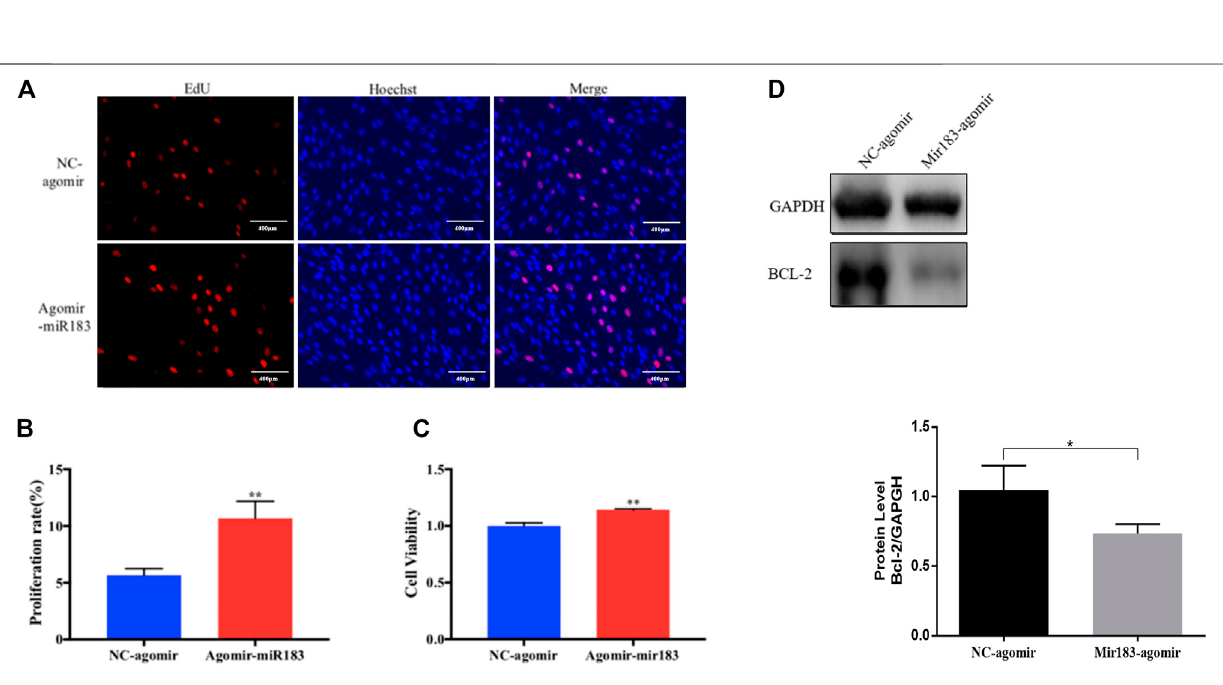
Frontiers in Genetics |